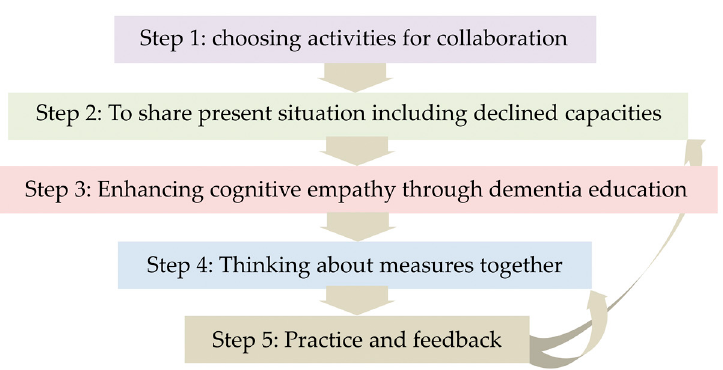
Figure 1. Intervention process is a trail-and-error procedure.